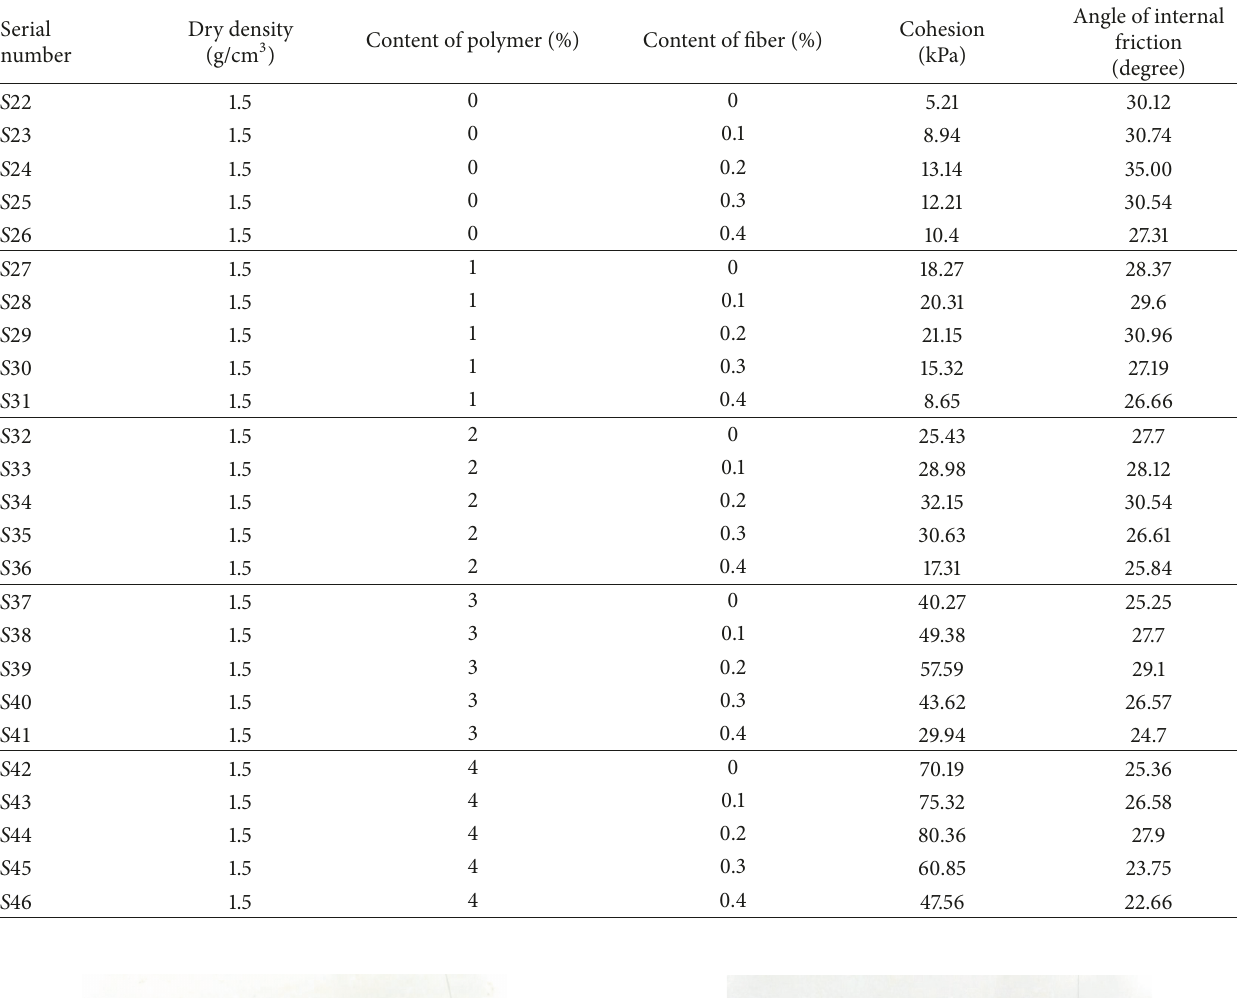
Table 4: Direct shear strengths of sand samples.